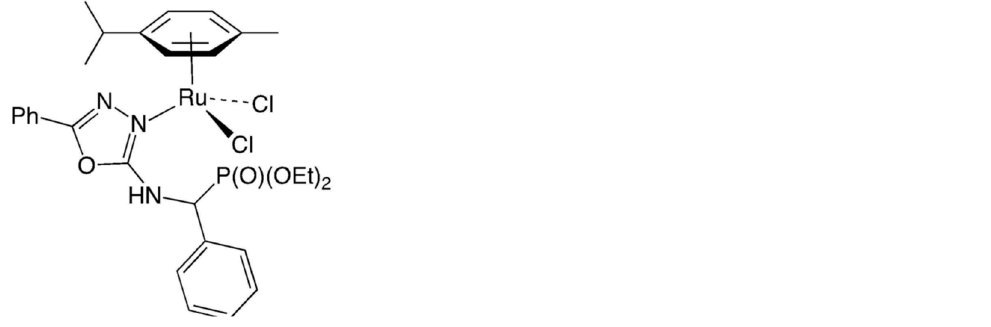
Figure 5. Neutral ruthenium(II) complex as a catalyst of arylmethyl alcohol oxidation (Hkiri S. et al., 2022) [65].